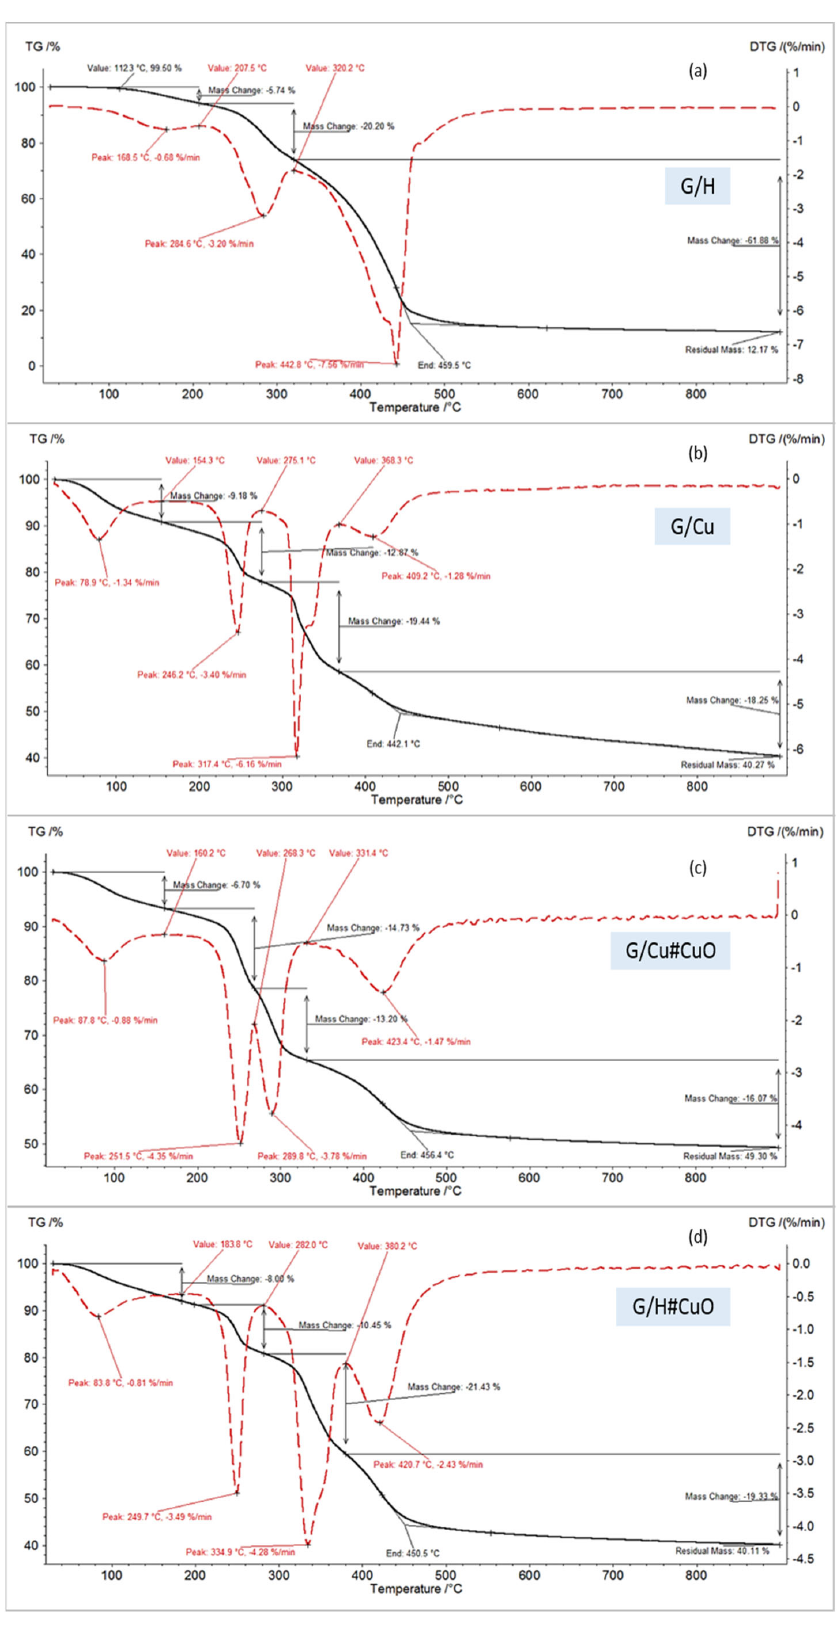
Figure 7. TG/DTG curves in N 2 of ( a ) G/H, ( b ) G/Cu, ( c ) G/Cu#CuO, and ( d ) G/H#CuO.